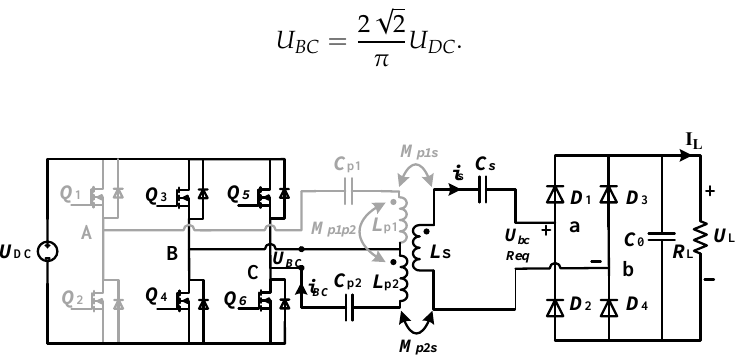
Figure 6. IPT system structure diagram in constant voltage (CV) mode.